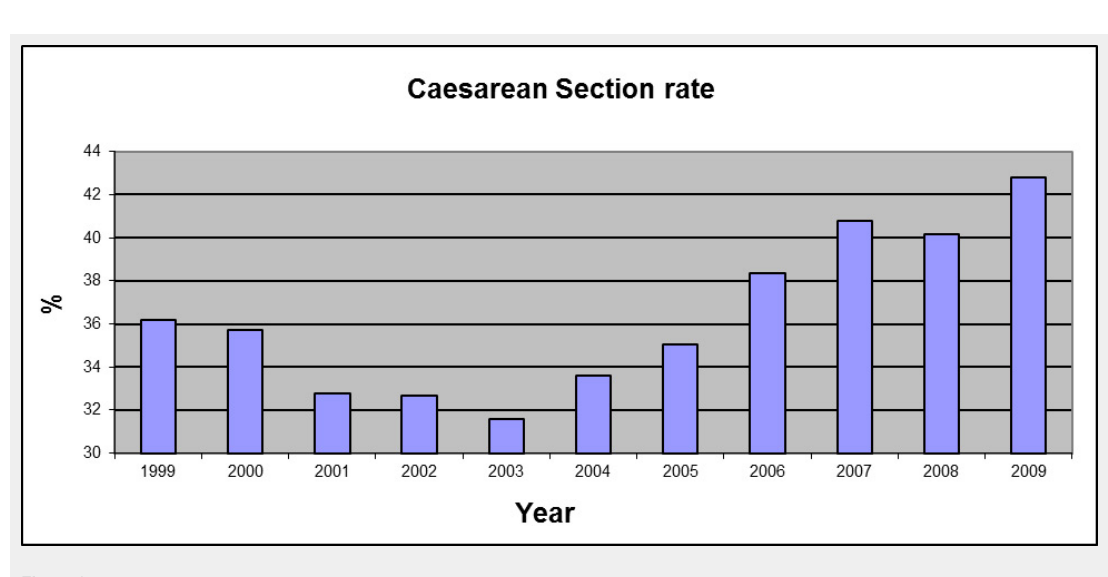
Figure 2 The overall caesarean section (CS) rate was 36.6% and increased significantly to 42.8% in 2009 (p